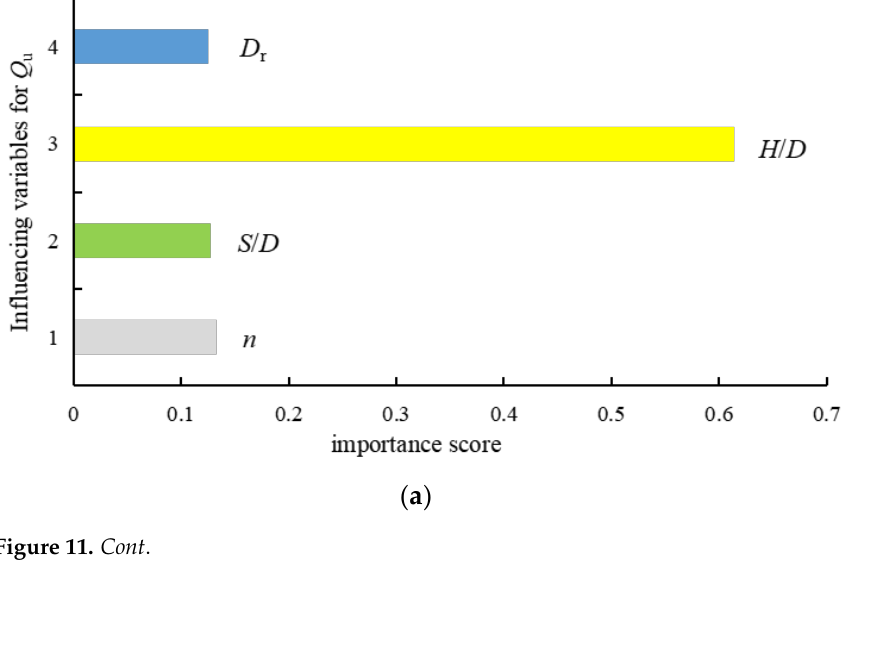
( b ) Figure 11. Importance score of influencing variables (1: n ; 2: S / D ; 3: H / D ; 4: D r ): ( a ) Q u , ( b ) u p. In general, the partial dependence plots and relative importance scores of influencing variables in this study highlight some important outcomes and indicate future potential experimental studies concerning Q u and u p in dense sand. These findings have particular importance for optimizing Q u and u p and represent a useful tool for helical anchor design. 4.4. Superiority and Limitations The primary strength of this study is the proposal of a novel strength prediction model based on GBDT and PSO for the Q u and u p prediction of helical anchors in dense fine silica sand. The proposed method was robust in predicting Q u and u p and the estab- lished model provides new insights into the importance of influencing variables. Broadly, the low-cost, less time-consuming, and non-destructive prediction of Q u and u p in this work will help to promote the utilization of helical anchors in engineering. In terms of limitations, the analysis in this work was focused on dense fine silica sand; thus, the lack of results for Q u and u p in medium–dense sand and loose sand is a clear limitation. In addition, data regarding the influence of soil particle size were not included